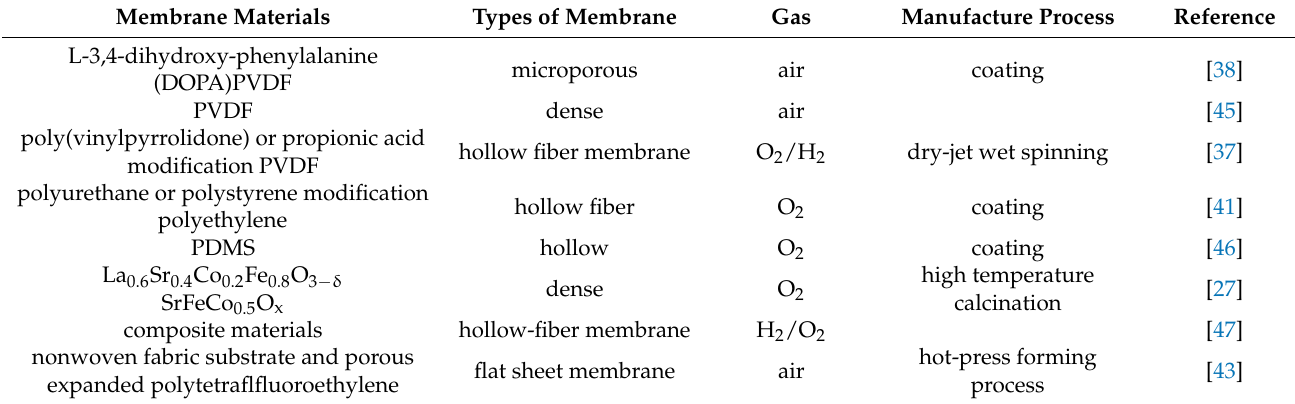
Table 1. Different kinds of gas-permeable membrane materials and their manufacturing